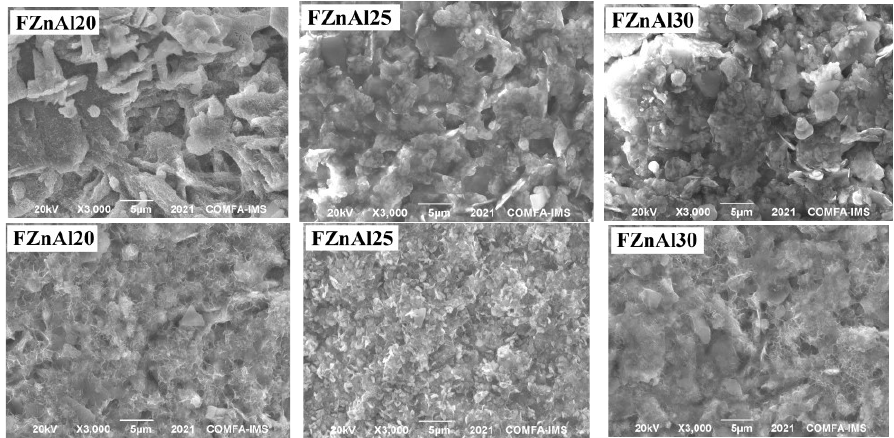
Figure 6. SEM images of the silicate coatings with different pigments: before (upper) and after (lower) 1000 h of salt spray test.